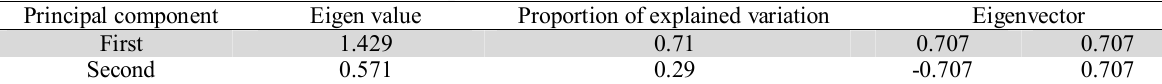
Results of PCA on SS values of the responses (case study 1) Principal component Eigen